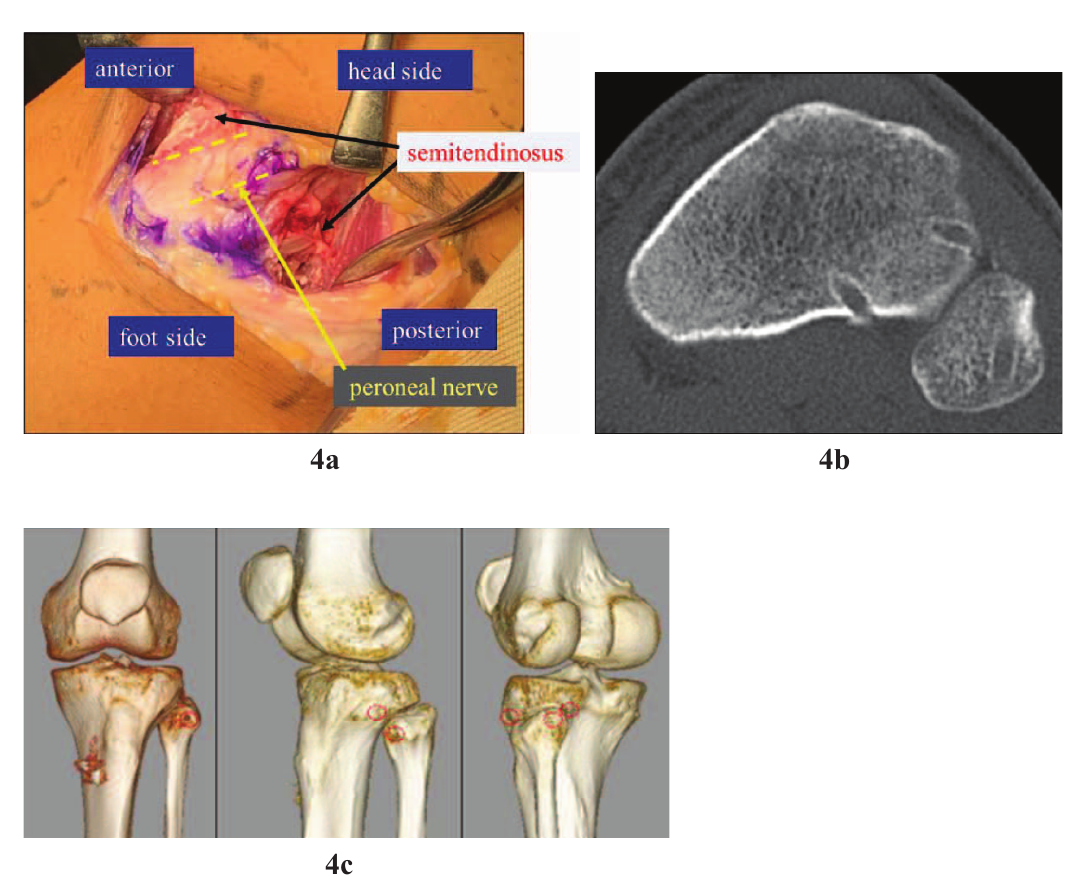
Figure 4. Operative method. A semitendinosus tendon graft was collected. Oblique skin incision was made centring the fi bular head and opened, con fi rming the common fi bular nerve. Bone tunnels were made according to the method described by Kobbe et al. [1]. The obtained semitendinosus tendon was passed through the transtibial and trans fi bular tunnels and fi xed to the pes anserinus using a stapler with maximum manual force at the knee joint fl exion angle of 30 (cid:1)